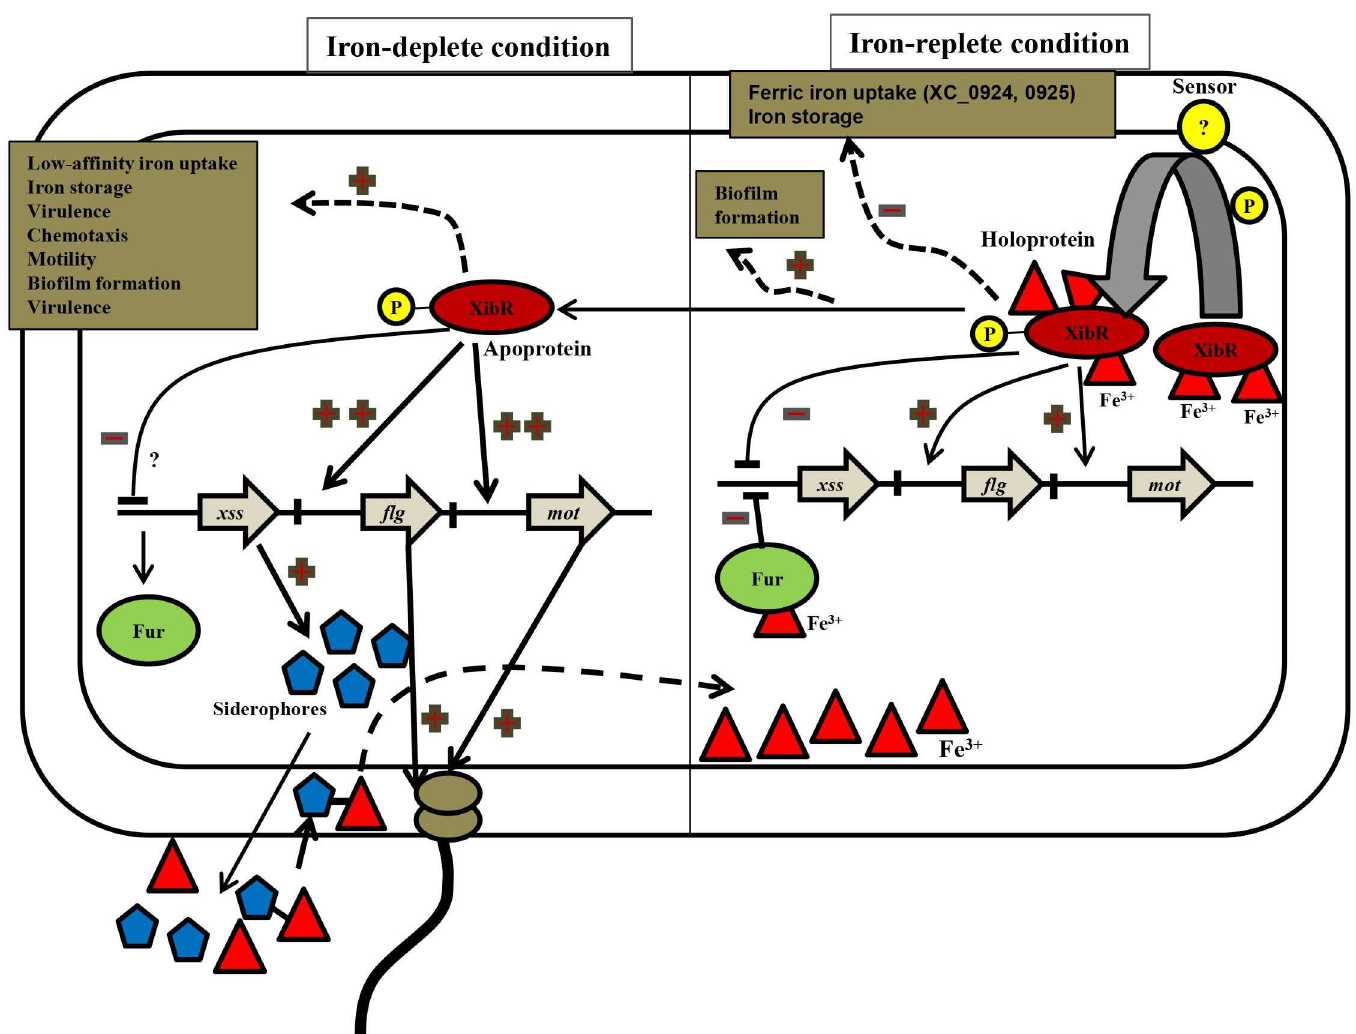
Fig 9. A proposed model for the role XibR in the regulation of iron homeostasis, chemotaxis, motility, biofilm formation, and virulence in Xcc. XibR is phosphorylated by a yet-unknown sensor kinase in responseto changein environmental conditionsuch as iron availabilityor host environment. Under iron- replete condition,holo-XibR(XibR-Fe 3+ ) represses expressionof Xanthomonas siderophore synthesis ( xss ) cluster along with Fur-Fe 2+ . XibR positively regulateschemotaxis and motility in Xcc. Under iron-deplete condition, wherein, the apo-XibRmay be the predominant form in the cell, may act as a